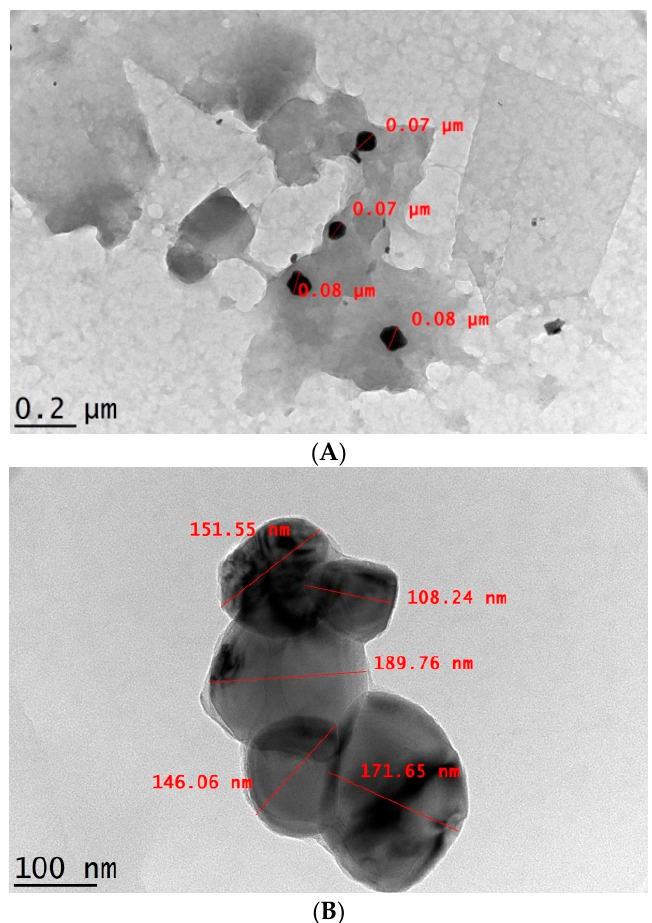
Figure 5. Images of Transmission Electron Microscopy (TEM) morphological analysis of ( A ) CNP° and ( B ) CNP°-CGA. Particles appeared as irregular spherical-shape for all parameters used.